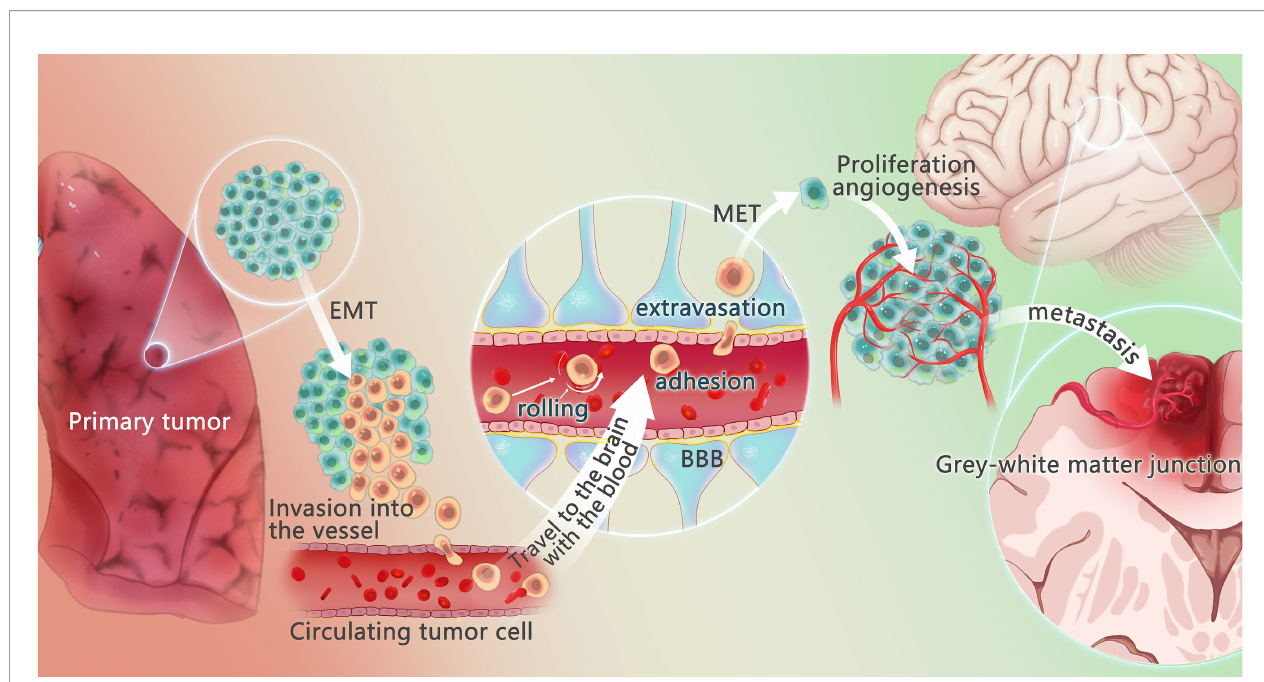
FIGURE 1 | Mechanism of lung cancer brain metastasis. The changes of tumor microenvironment may promote some tumor cells to undergo epithelial- mesenchymal transition (EMT) process, to get the potential of metastasis and avoid apoptosis. These tumor cells escape from the primary tumor in the lung, invade the vessels, and circulate through the vessels, called circulating tumor cells (CTCs). Under the action of chemokines, CTCs reach the brain, cross the blood-brain barrier through rolling, adhesion and extravasation under the effect of E-ligand and integrin, undergo mesenchymal-epithelial transformation (MET) to regain the characteristic of the primary tumor, recover the characteristics of the primary tumor, and produce and adapt to the new tumor microenvironment. Angiogenesis is required for the growth of metastases. When pure oxygen diffusion is not suf fi cient for the tumor, the tumor gradually develops a hypoxic microenvironment and overexpress angiogenesis-stimulating factors, promoting the angiogenesis. The brain metastasis often happens in the gray and white matter junction and vascular border zones, where there is a longer mean transit times (MTT)of blood fl ow, providing more chance to overcome the blood-brain